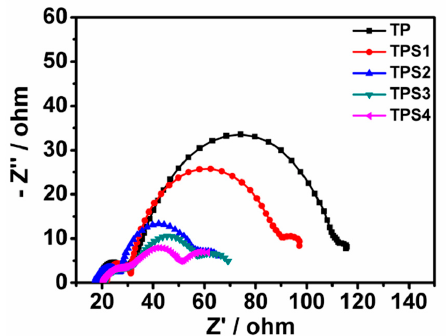
Figure 6. Nyquist plots of various SnO 2 photoanode films–based DSCs.